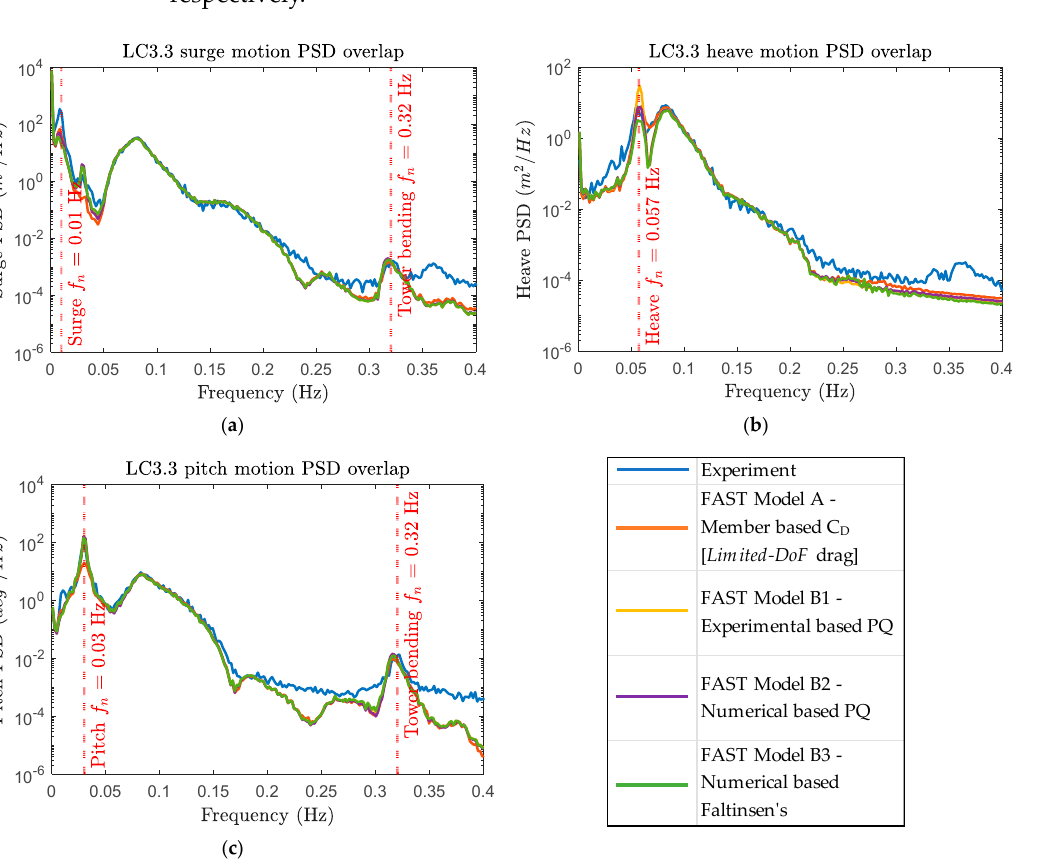
Figure 6. OC5 FOWT platform motion power spectral density (PSD) for LC3.3: ( a ) Surge motion PSD; ( b ) heave motion PSD; ( c ) pitch motion PSD. For the surge motion PSD, the frequency response amplitudes for the system natural frequencies at surge (0.01 Hz), pitch (0.03 Hz), and tower bending (0.32 Hz) are shown for both experimental and numerical model (Models A, B1-B3). All the models underesti- mated the response amplitude for surge natural frequency, with the limited-DoF Model A better representing the low-frequency surge response compared to the drag matrix mod- els (B1-B3). In contrast, the amplitude associated with surge-induced pitch was not well represented by Model A and was overestimated by the drag matrix models. All the mod- els estimated similar amplitudes for tower bending and were close to the experimental results.